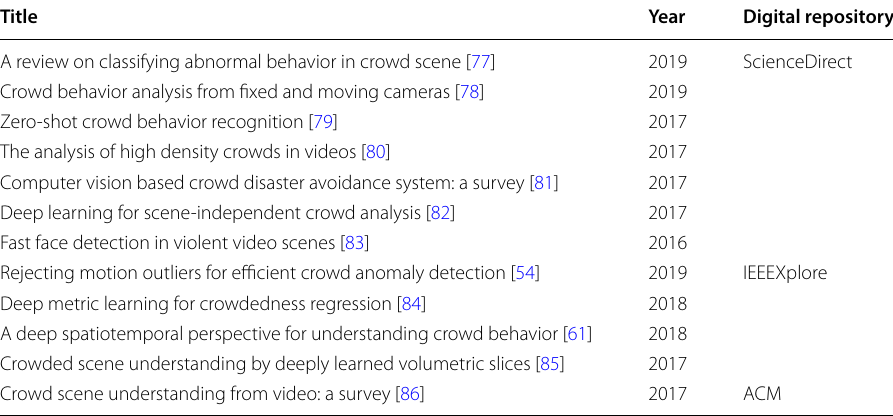
Table 6 Papers specific to crowd behavior analysis, under deep